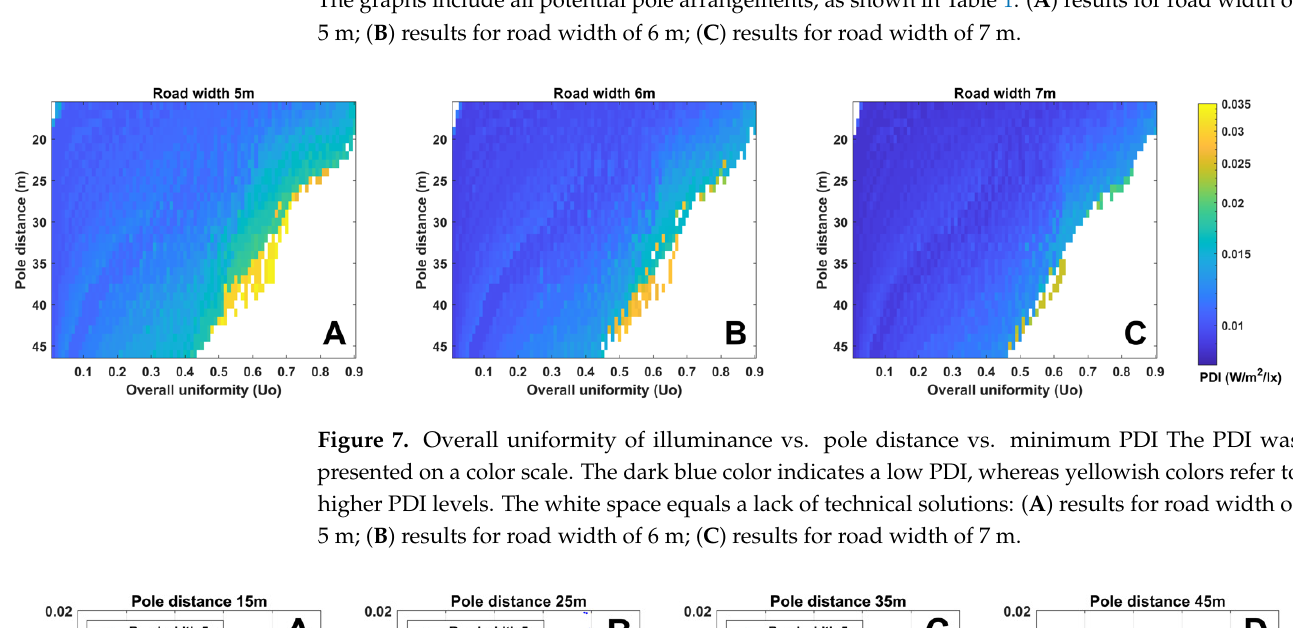
Figure 7. Overall uniformity of illuminance vs. pole distance vs. minimum PDI The PDI was pre- sented on a color scale. The dark blue color indicates a low PDI, whereas yellowish colors refer to higher PDI levels. The white space equals a lack of technical solutions: ( A ) results for road width of 5 m; ( B ) results for road width of 6 m; ( C ) results for road width of 7 m.